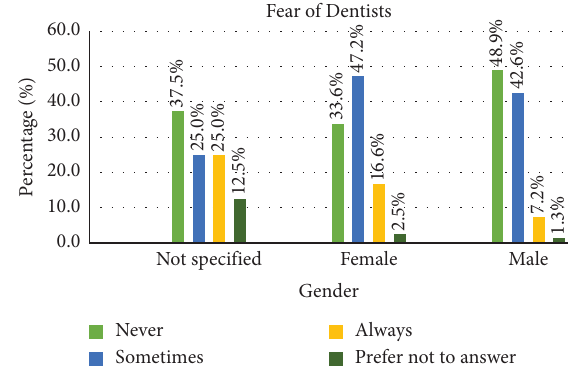
Figure 1: Te percentage of responses to “do you fear dentists” by gender.